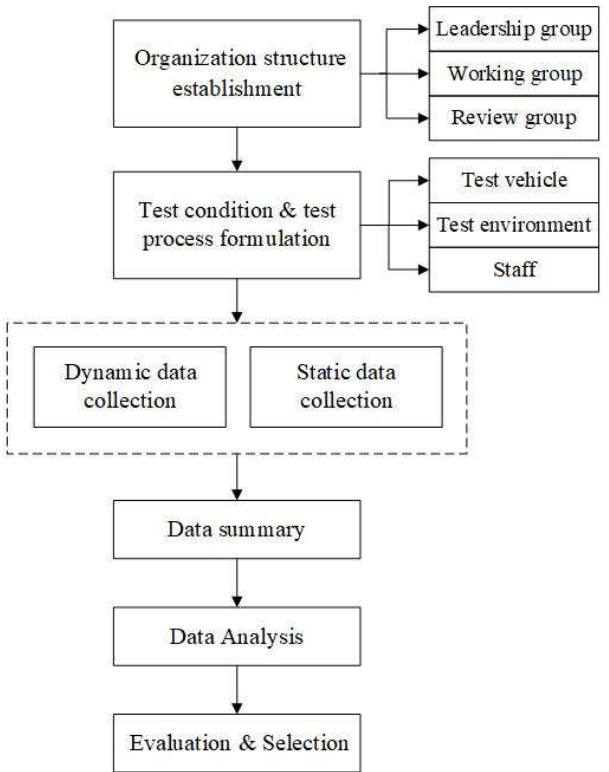
Figure 6. Flow chart of road test operation. Table 3. Operation Arrangement.